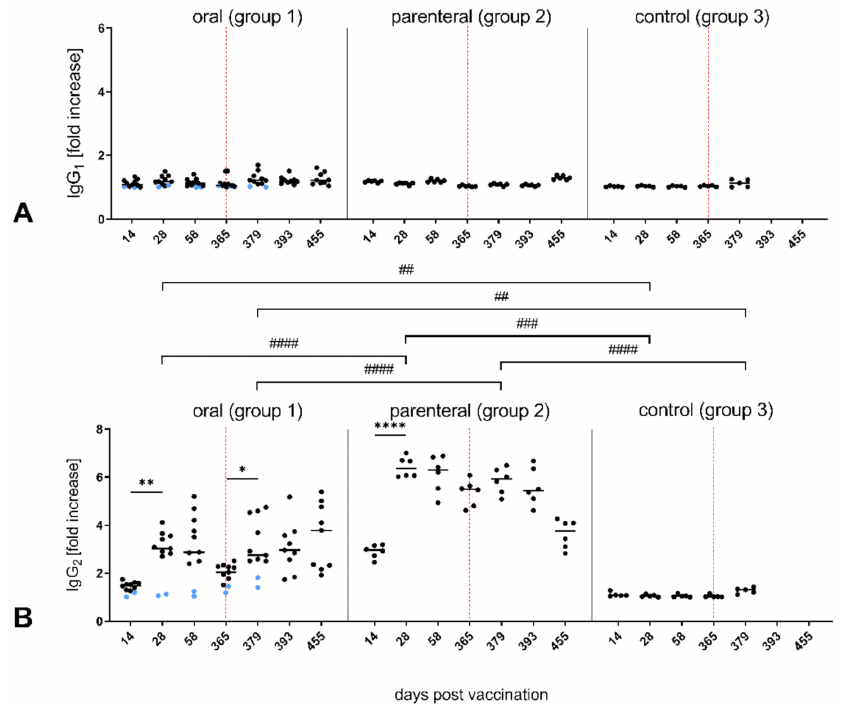
Figure 3. Kinetics of RABV-specific IgG subclasses IgG1 ( A ) and IgG2 ( B ) in serum of vaccinated and naïve foxespost vaccination and post challenge. Data are expressed as fold change values for individual animals (dots) and as mean (horizontal line) for each sampling time point and group. Seronegative foxes (No ◦ 34 and 41) in the orally vaccinated group are shown in blue. Statistically significant differences between consecutive sampling time points within groups are denoted as follows: * p ≤ 0.01; ** p ≤ 0.005; **** p ≤ 0.0001, while those between groups were denoted by ## p ≤ 0.01; ### p ≤ 0.005; #### p ≤ 0.001. The vertical dotted line indicates the Time Point of challenge (365